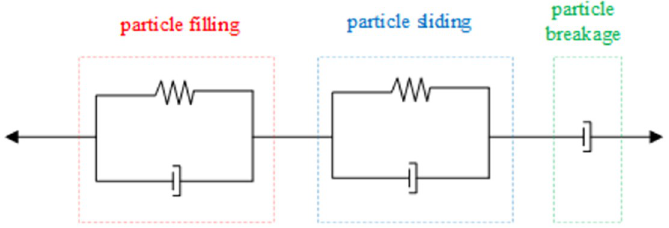
Fig 11. Composition of the compaction constitutive